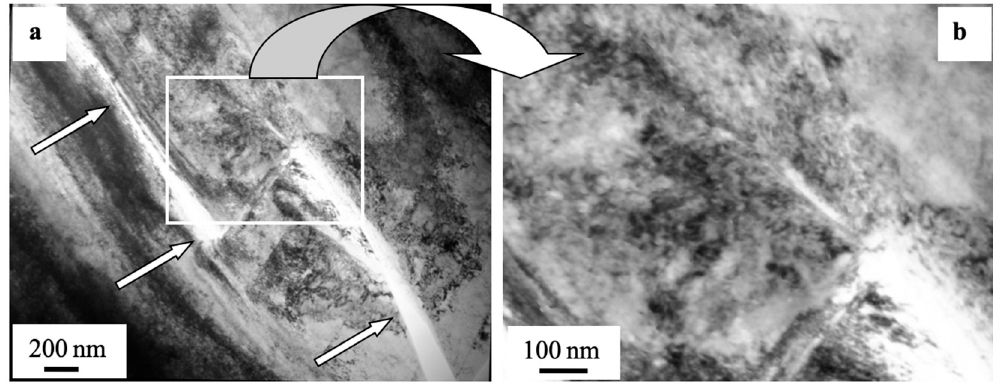
Figure 10. Electron microscopic image of a microcrack (indicated with the arrow ( a )) detected in a ~10 µm deep layer in AISI 310S steel irradiated with an electron beam and fractured when fatigue testing; ( b ) shows a zoomed image of the zone presented in ( a ).